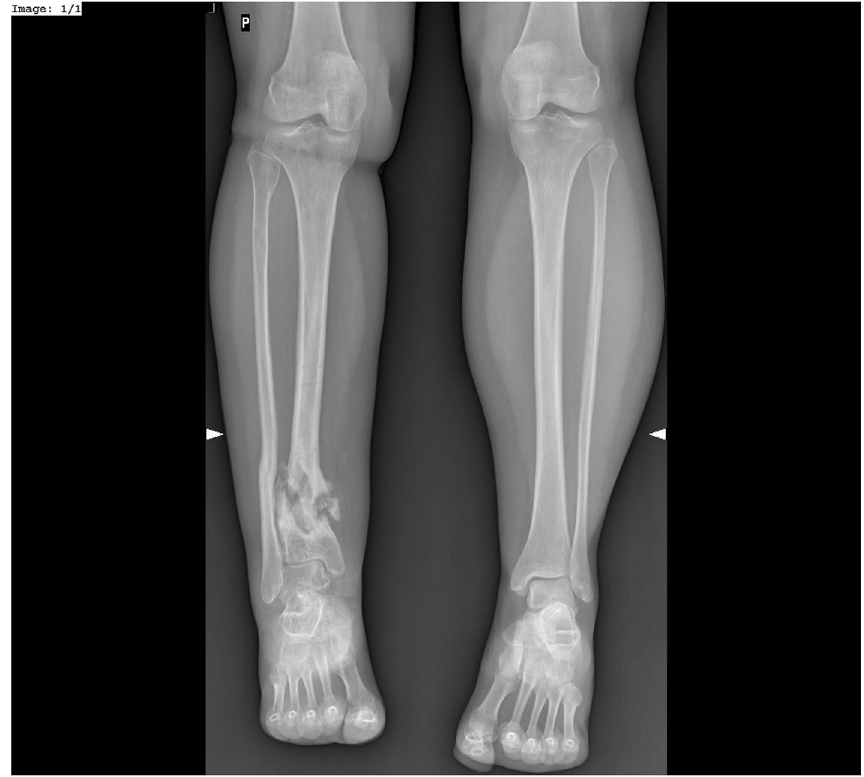
Figure 1. Hypertrophic non-union of 1/3 distal tibia a–p